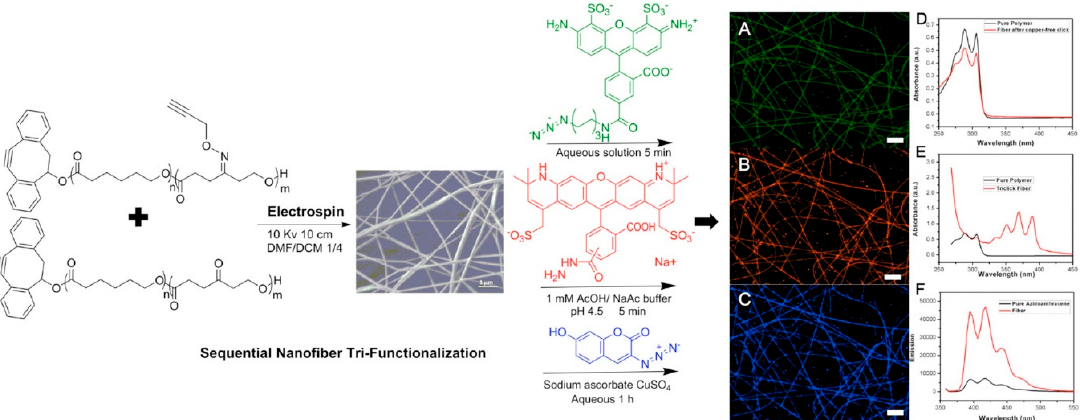
Figure 17. ( A – C ) Fluorescence images showing successful sequential trifunctionalization of